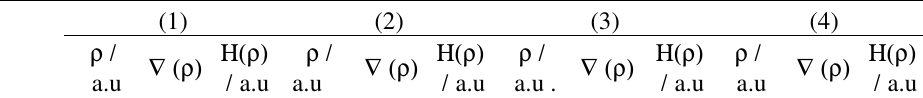
Table 3. Charge density ( ρ ), electron density ( ∇ ( ρ  ), and energy density at the bond critical points (bcp) of tautomer A of 5-methyl-imidazolidine.